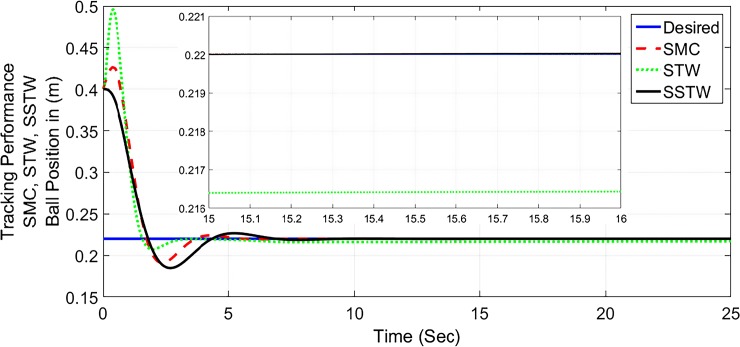
Output tracking performance of SMC, STW, and SSTW, rd = 22cm.